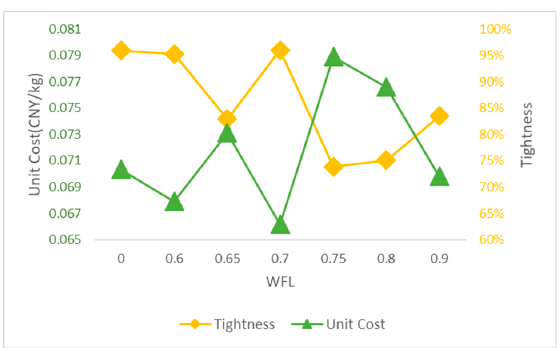
Figure 4. Changes of Tightness and Efficiency at Diffident WFLs.